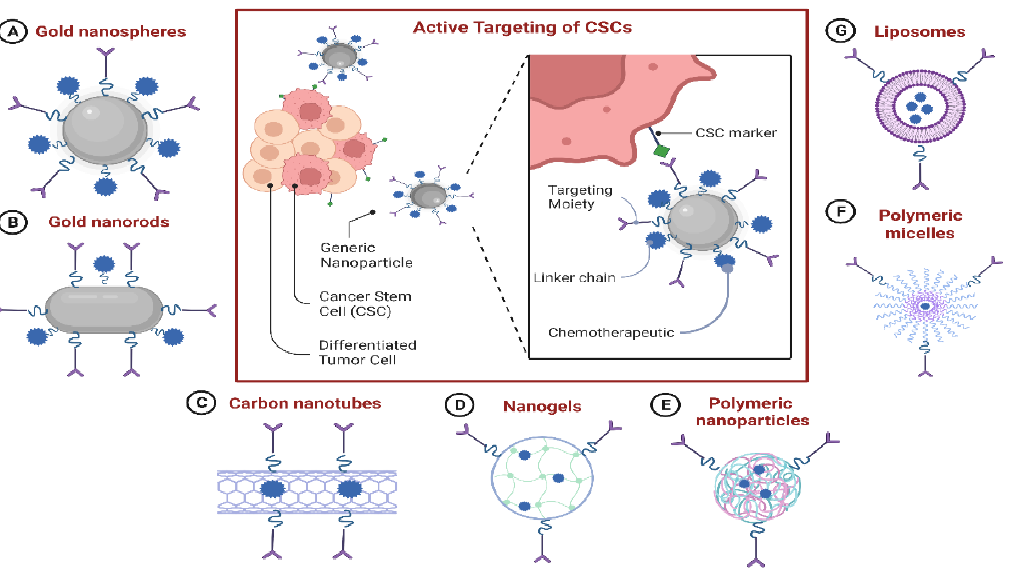
Figure 7. Schematic illustration revealing the various promising types of nanoparticles that contribute to nanoparticle-mediated targeted drug delivery to CSCs .